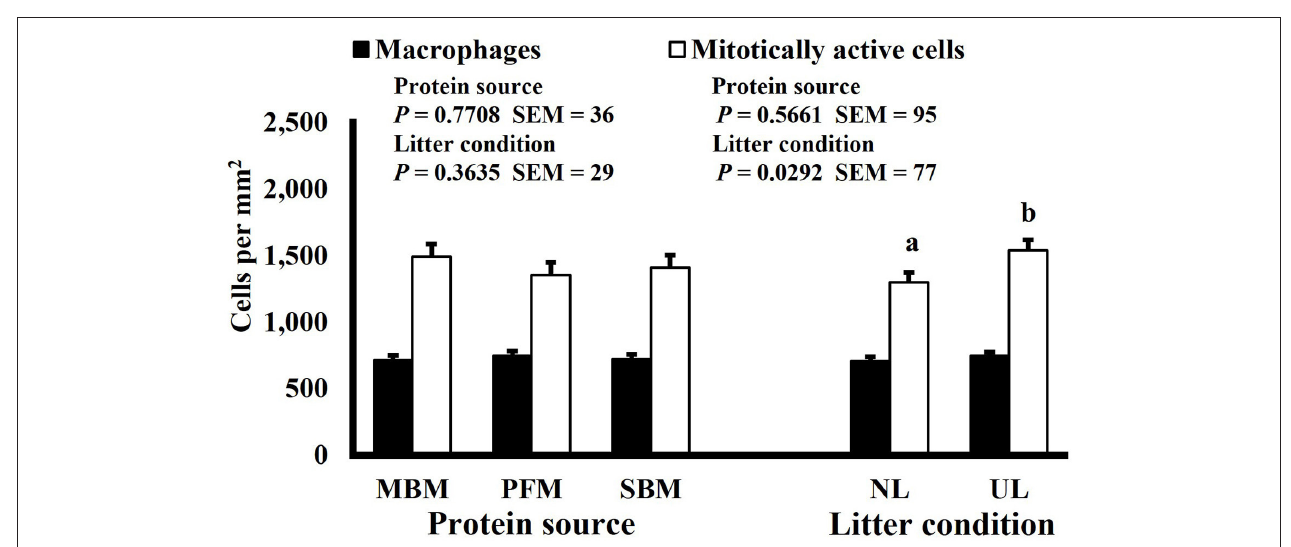
FIGURE 3 | Effect of dietary protein source and litter condition on macrophage (KUL01 + ) and mitotically active (BrdU + ) cell densities (cells per mm 2 ) in the ileum of 21-d-old broilers ( n = 36 per sampling d, 6 birds per treatment). MBM, meat and bone meal; PFM, 50% poultry by-product and 50% feather meal blend; SBM, soybean meal; NL, new litter; UL, used litter. a,b Bars of the same color representing means from either dietary protein source or litter condition with different superscripts differ at P ≤